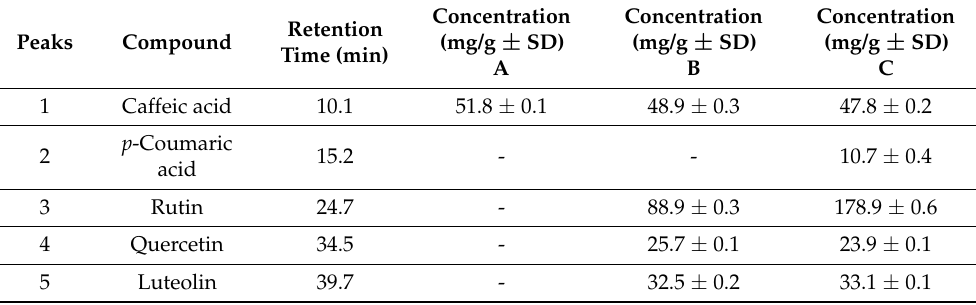
Figure 4. Chromatograms obtained from aqueous extract samples of ( A ) Alibertia edulis , ( B ) Alibertia intermedia , and ( C ) Alibertia sessilis leaves. Table 3. Compounds identified and quantified by HPLC